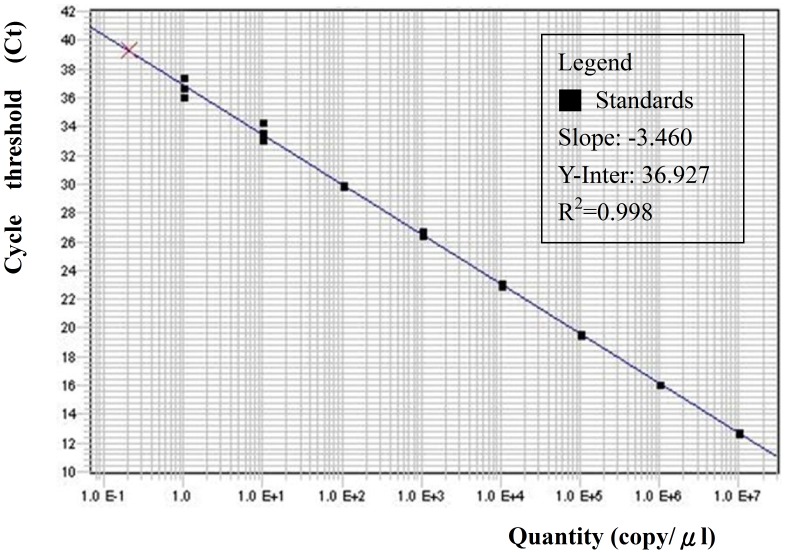
Standard curve of known DNA (1.0×100 to 1.0×107 copies/µl) and threshold cycle (Ct) measured using a real-time qPCR for B. pseudomallei with R2 of 0.998 and slope of −3.46.